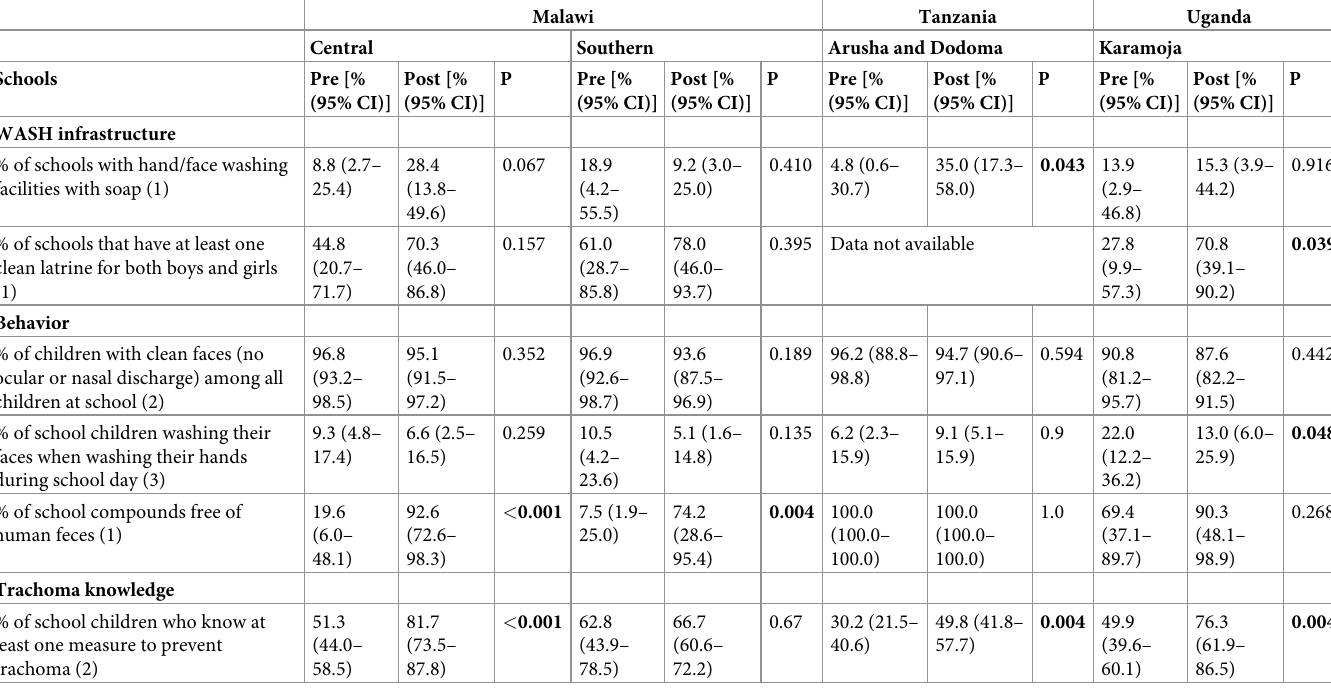
Table 4. Survey results by school evaluation unit at pre and